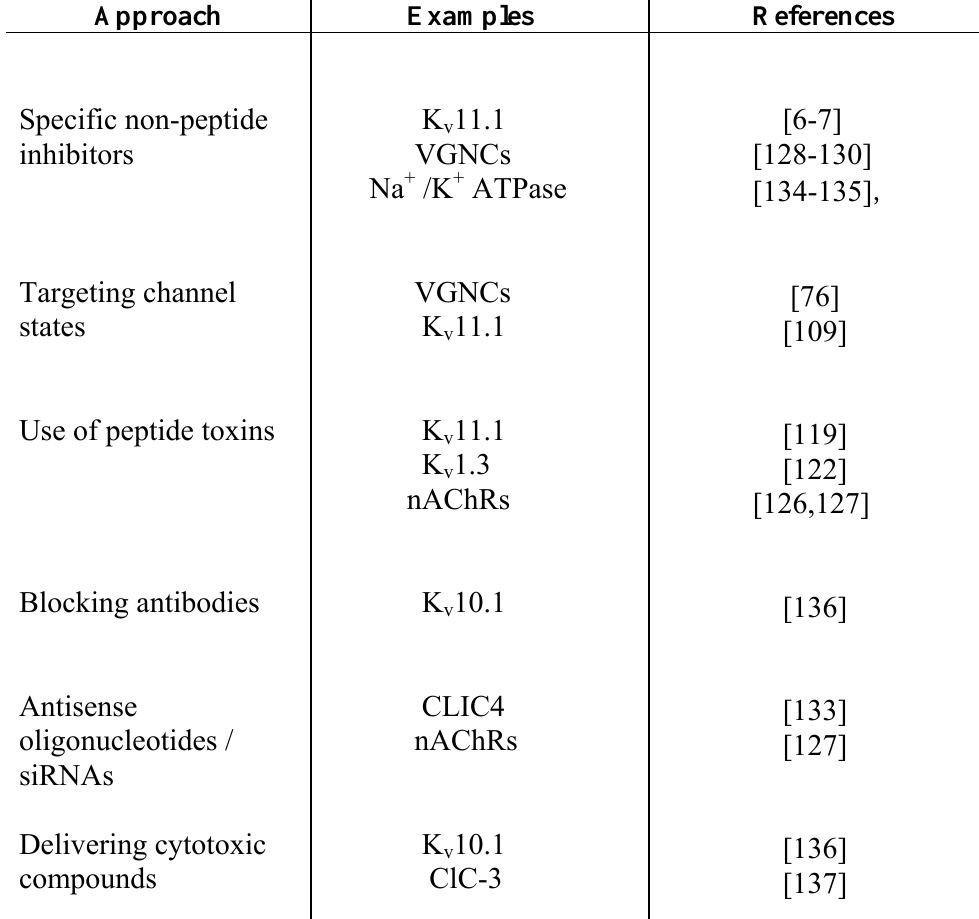
Table 2. Possible approaches to target ion channels and transporters in